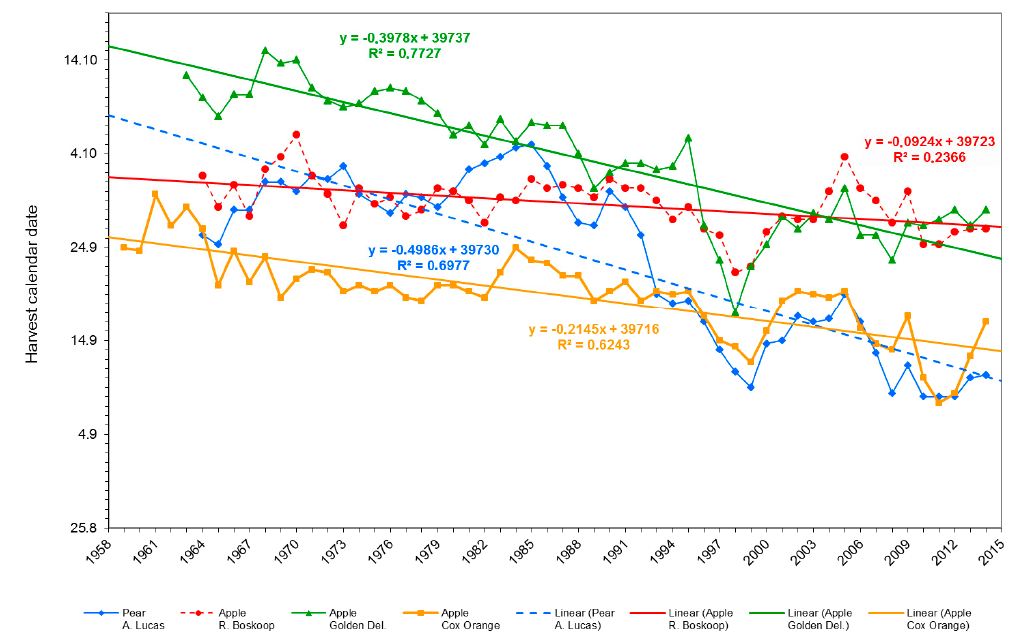
Figure 6. Effect of recent climate change on fruit maturity, viz harvest calendar date of apple cvs ‘Golden. Delicious’ (green), ‘Boskoop’ (red), ‘Cox Orange’ (yellow) and pear cv. ‘A. Lucas’ (blue dotted line) fruit (with moving averages and R 2 ).